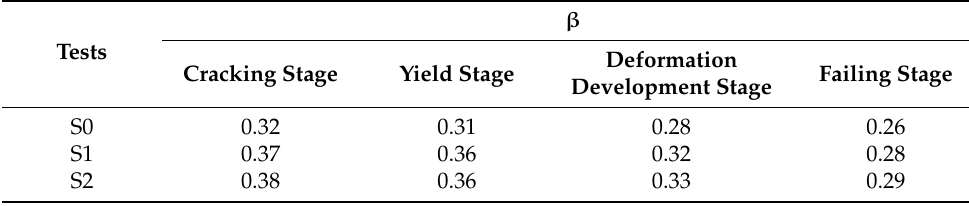
Table 3. Equivalent viscous coefficient